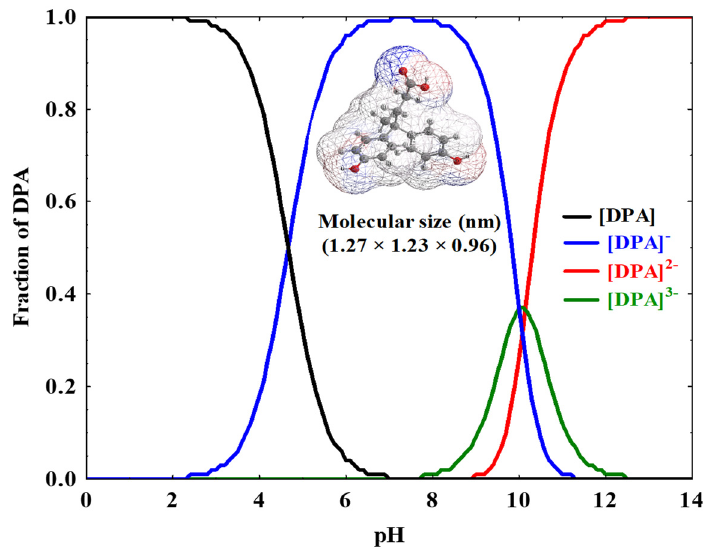
Figure 2. Species distribution, chemical structure, and molecule size of DPA.